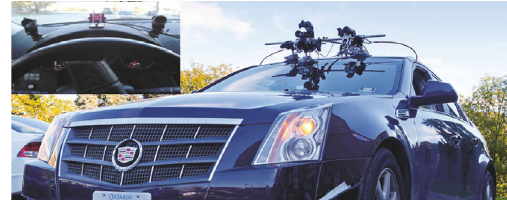
Figure 1: RoadLAB: the instrumented vehicle depicted with its rooftop stereoscopic vision system and driver gaze tracker (top-left).